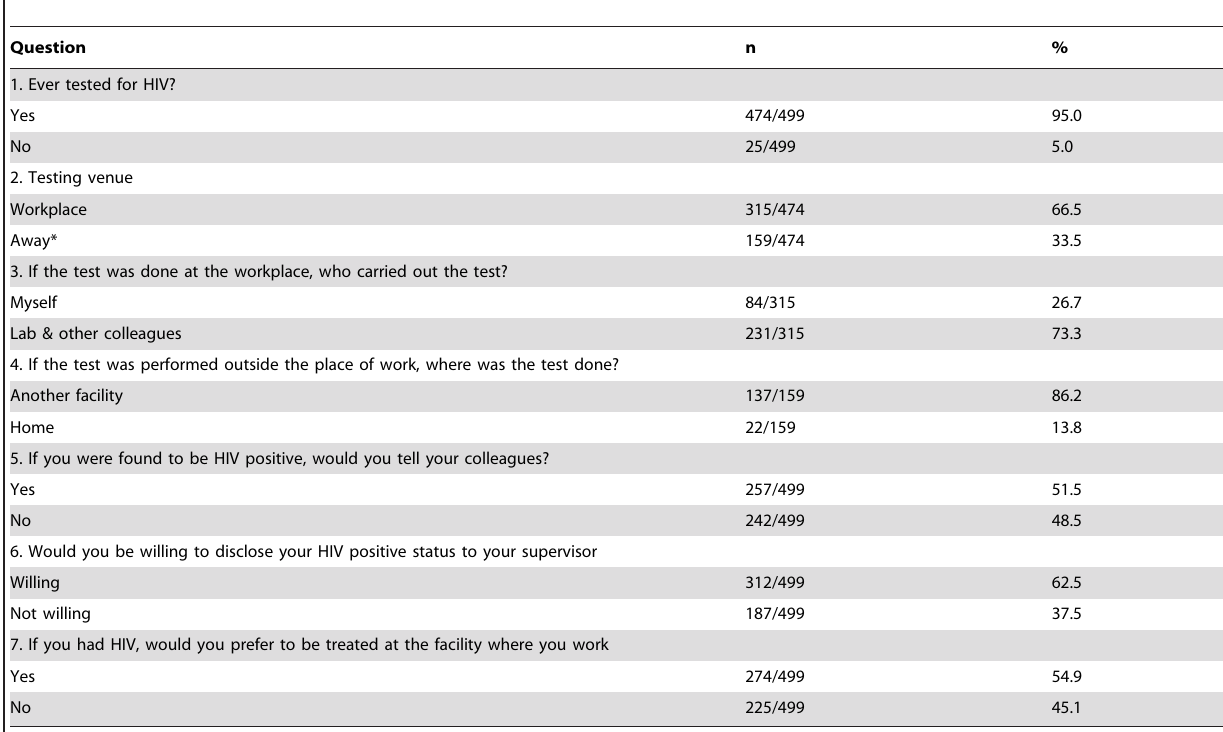
Table 2. Utilisation of HIV counselling and testing services and willingness to disclose HIV positive status among health care workers in Mukono and Wakiso districts in